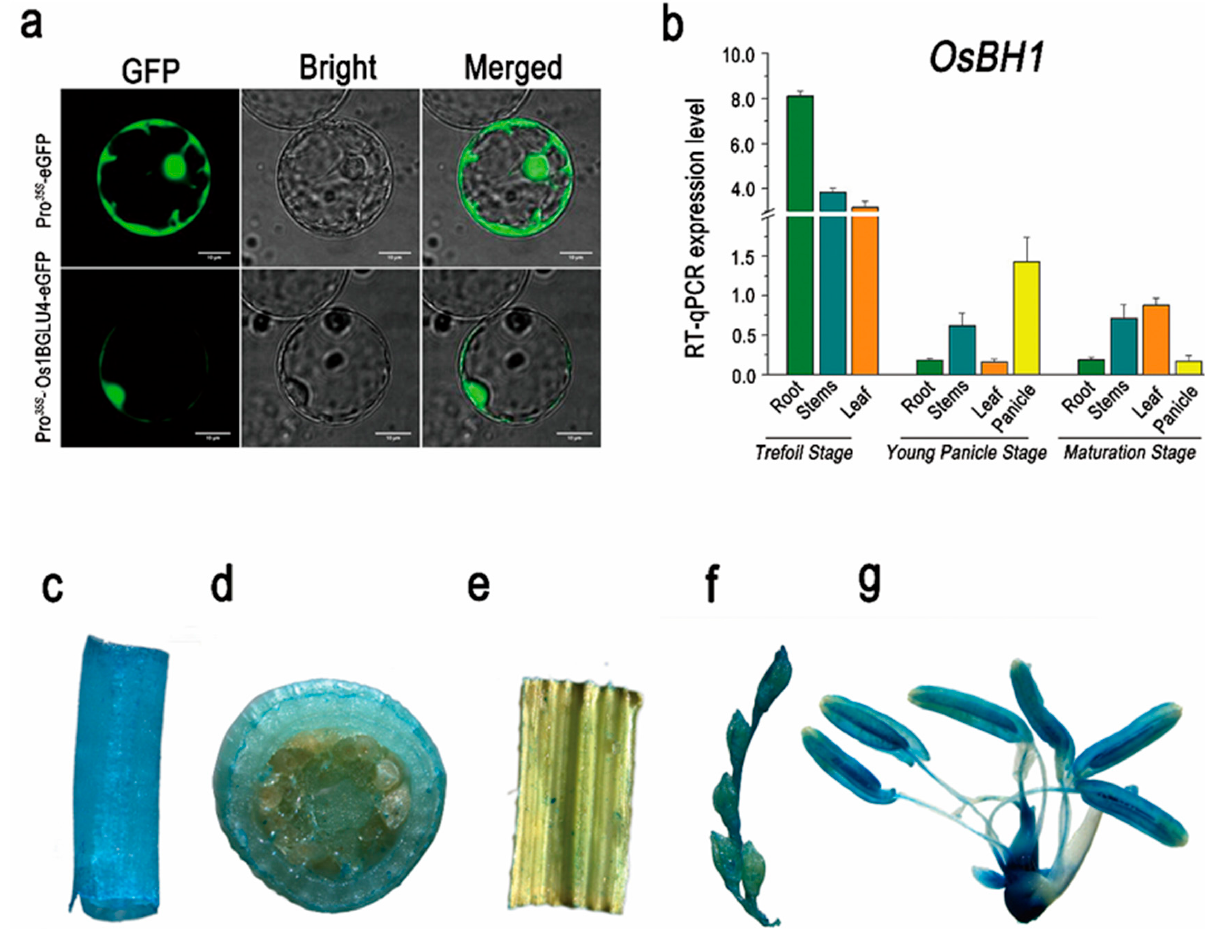
Figure 6. Subcellular localization, relative expression and GUS promoter assay of β -glucosidase (Os1 β Glu4) . ( a ) Subcellular localization of Os1 β Glu4 -eGFP fusion protein, ( b ) Relative expression level of Os1 β Glu4 in different tissues at trefoil leaf stage, young panicle stage and maturation stage, GUS promoter expression analysis in ( c ) root, ( d ) stem, ( e ) leaf, ( f ) young spikelets and ( g ) floret. 2.5. Os1 β Glu4 Can Hydrolyze SAG In-Vitro and InVivo Previously, it was reported that Os1 β Glu4 could hydrolyze p-nitrohenyl (pNP)- β - D -glucoside, β -(1-3) linked oligosaccharides, salicin, and esculin in-vitro [39]. To